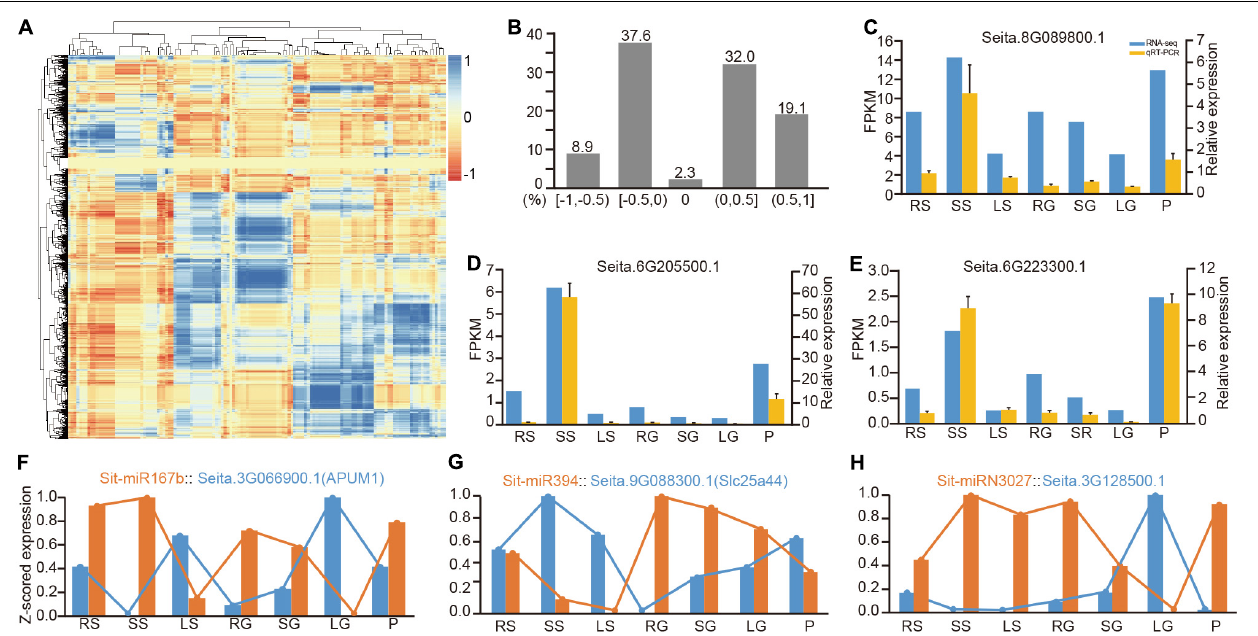
FIGURE 4 | Correlation analysis of the expression between miRNAs and their target genes. (A) Correlation matrix of expression between all miRNAs and their targets. (B) Distribution of the correlation of miRNA-target expression in divided sections of r (correlation value). (C–E) The comparison between quantitative results from RNA-Seq and their relative expression from qRT-PCR. (F–H) Three representative examples of the negative correlation of conserved miRNA, Poaceae-specific miRNA and foxtail millet-specific miRNA with their target transcripts, respectively. qRT-PCR, real-time quantitative reverse transcription